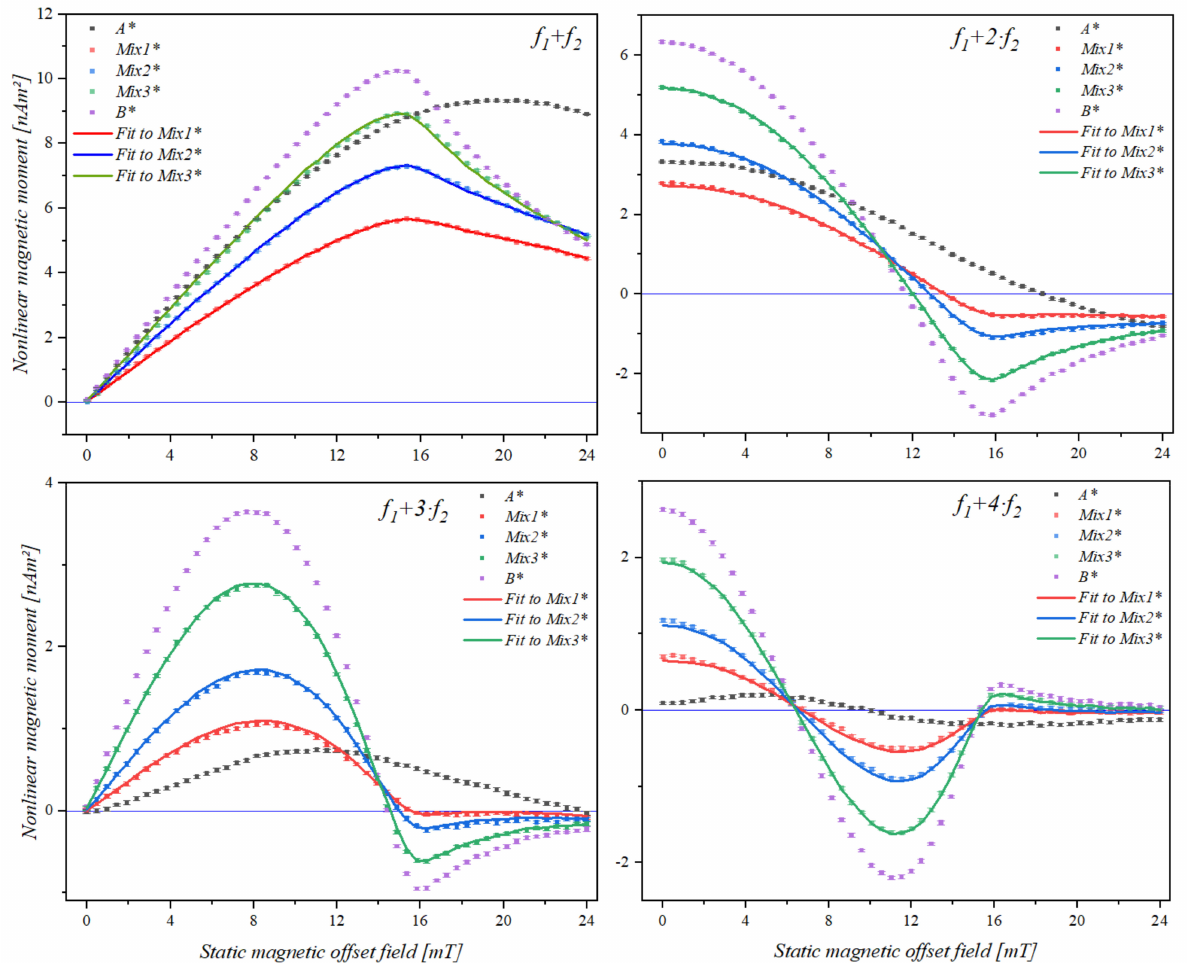
Figure 6. Nonlinear magnetic moment trace (mean and standard deviation within point size) of samples made from a mixture of two different types, 1 µ m Nanomag/SynomagCLD (A*) and 1 µ m SynomagD (B*), diluted to 7% of its original concentration. The responses of the mixture samples of the two bead types (Mix1* to Mix3*), prepared according to the ratios specified in Table 2, at mixing frequencies f 1 + f 2 , f 1 + 2 · f 2 , f 1 + 3 · f 2 and f 1 + 4 · f 2 were recorded over a static magnetic offset field range from 0 to 24 mT. The response of the mixture samples was analyzed using the QP algorithm for determination of the